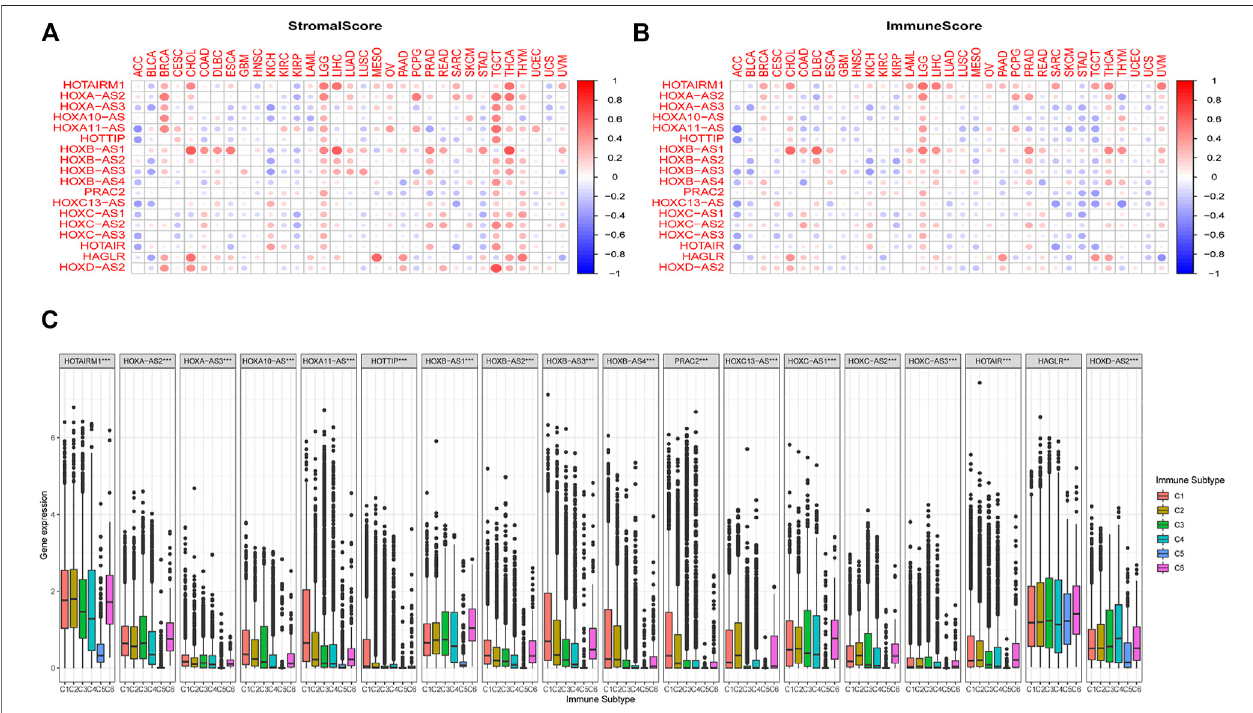
FIGURE 3 | Relationship between the expression of the homeobox antisense transcripts (HOXATs) and the tumor microenvironment. The correlation matrix of the HOXATs expression and the stromal cells (A) as well as the immune cells (B) of 33 different cancer types based on the estimation algorithm. The Spearman correlation analysiswasusedtotesttheimmunescoresand estimatescores.Thesizeofeachpoint represents theabsolutevalueofthecorrelationcoef fi cient,wherethelargerthe size, the higher the correlation (the higher the absolute value, the higher the correlation coef fi cient). Relationship between the expression of the HOXATs and the immune-in fi ltratingsubtypesacrossallcancertypes (C) .C1:woundhealing,C2:INF-rdominant,C3:in fl ammatory,C4:lymphocytedepleted,C5:immunologicallyquiet, and C6: TGF β